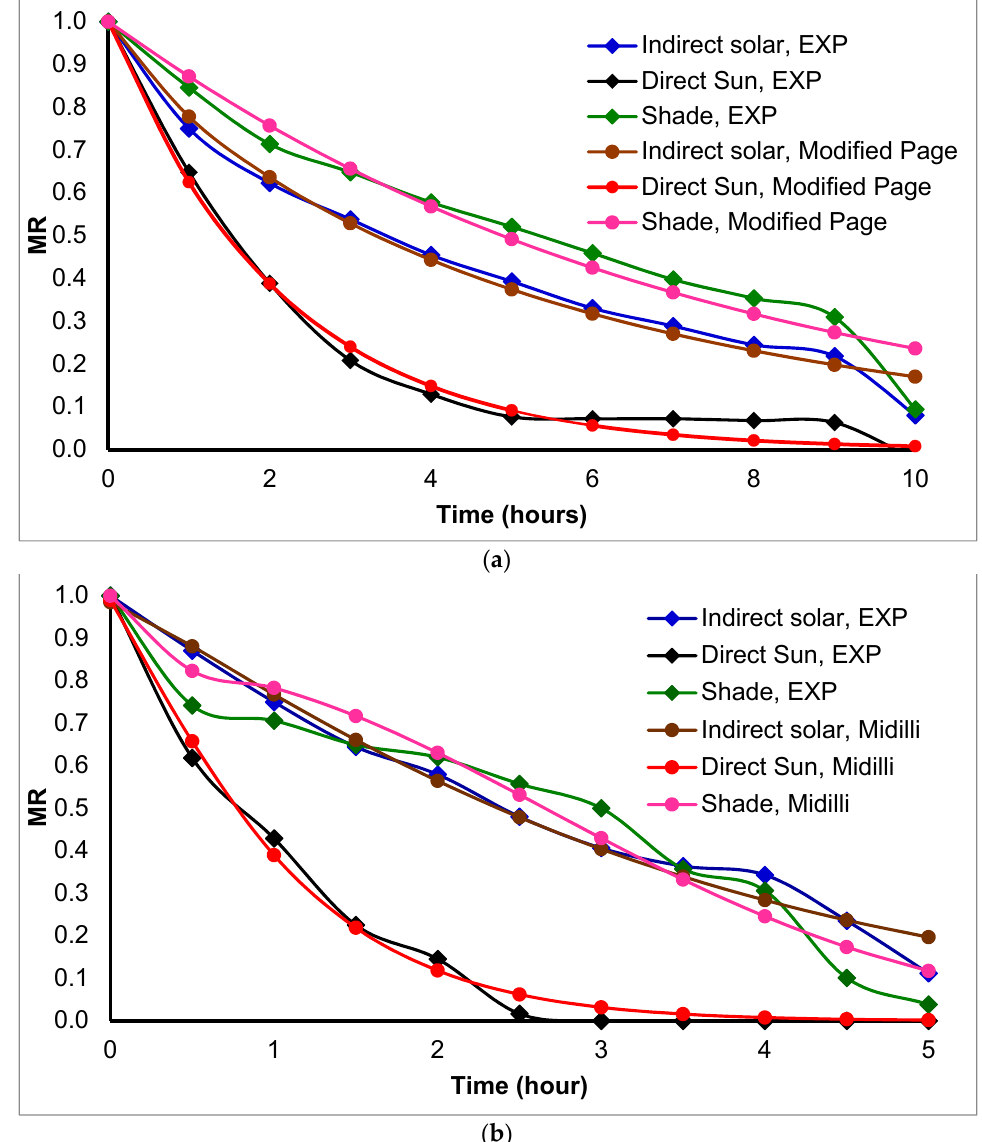
Figure 4. Drying kinetic model resemblance for Basil drying during the ( a ) winter and ( b ) summer seasons.